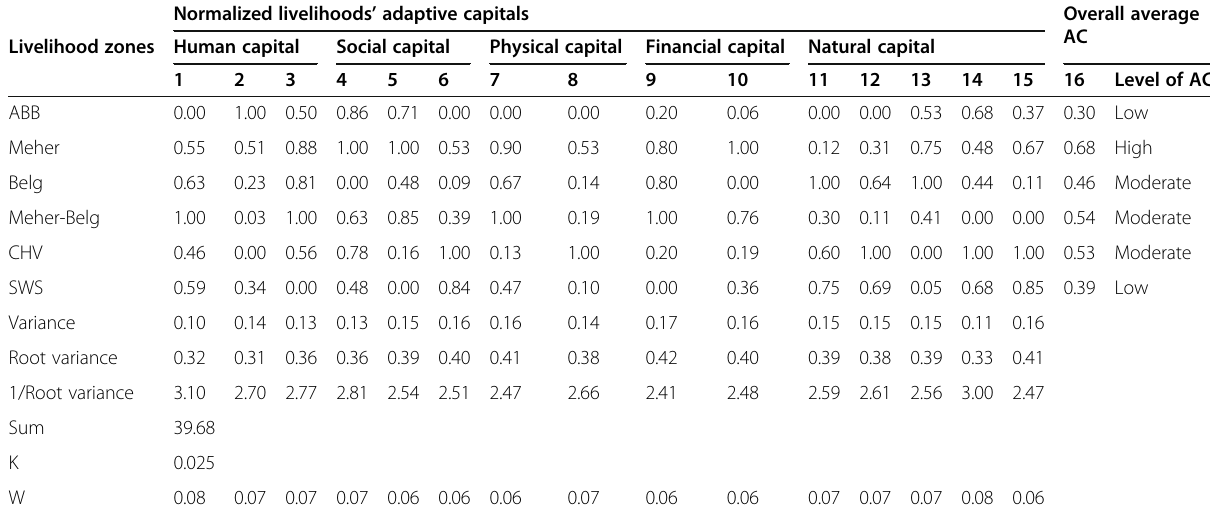
Table 6 Normalized livelihoods ’ adaptive capitals and overall average level of adaptive capacity across the livelihood zones Normalized livelihoods ’ adaptive capitals